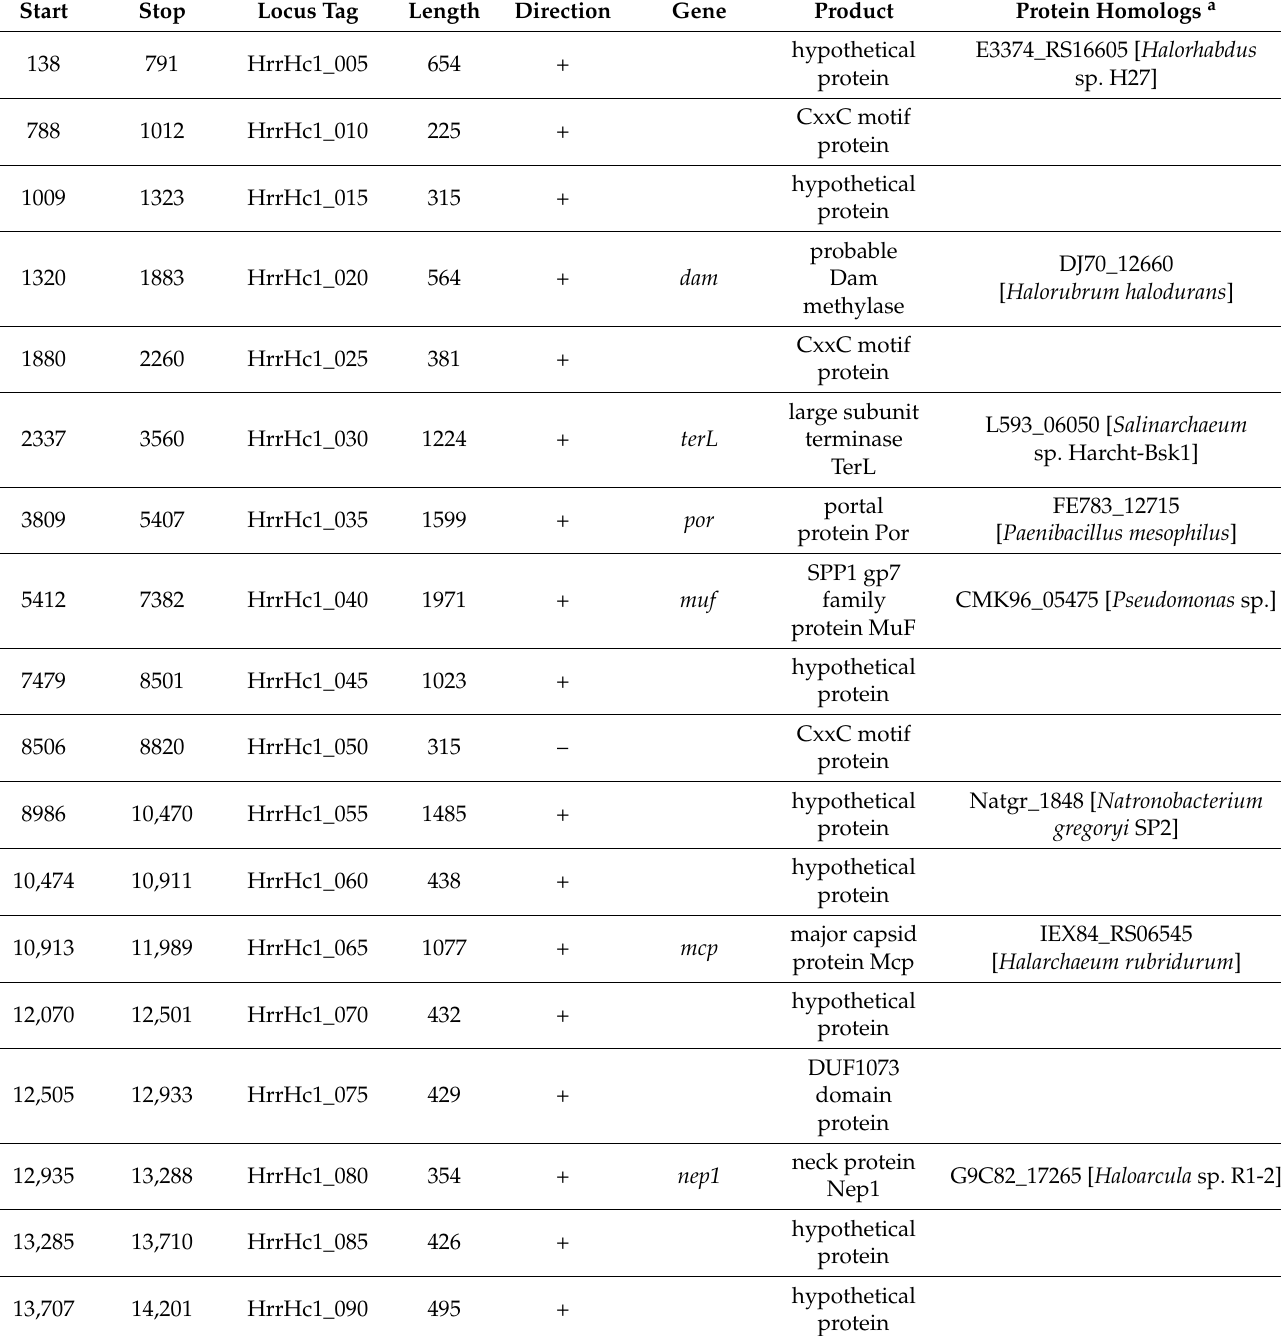
Table 5. Annotated CDS of halovirus Hardycor1